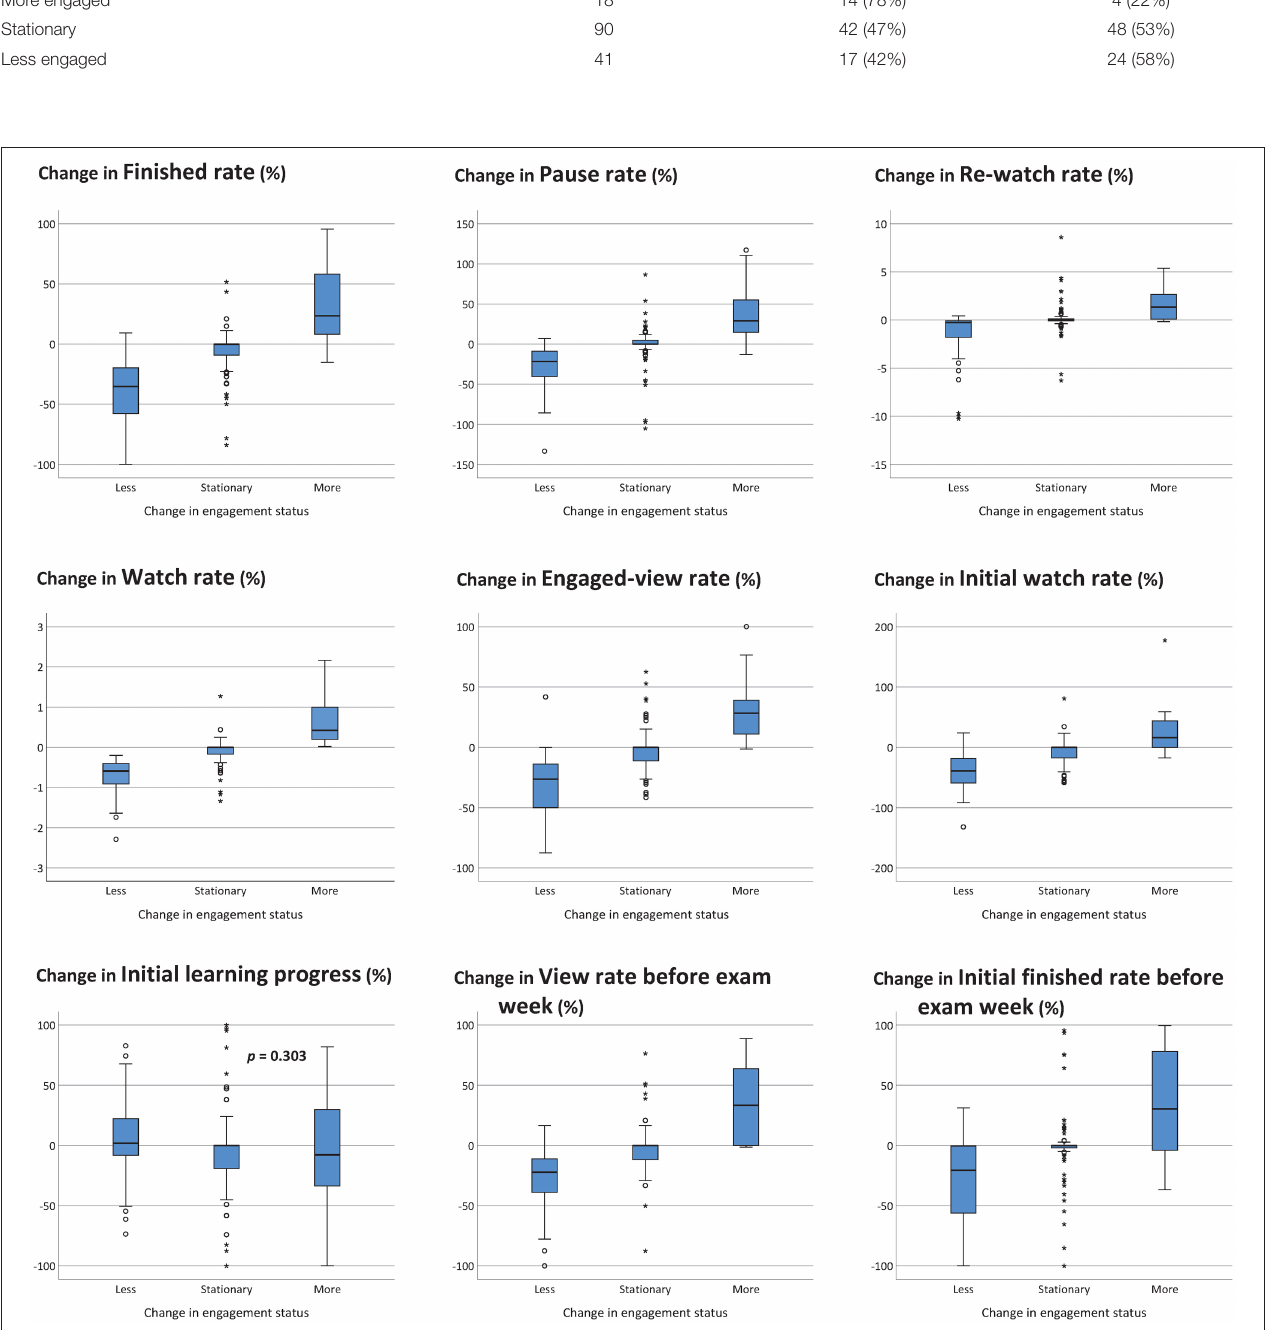
FIGURE 4 | Engagement level changes and watching behavior adjustments ( p < 0.001 for all unless otherwise mentioned). *represents extreme value; ◦ represents potential outlier.